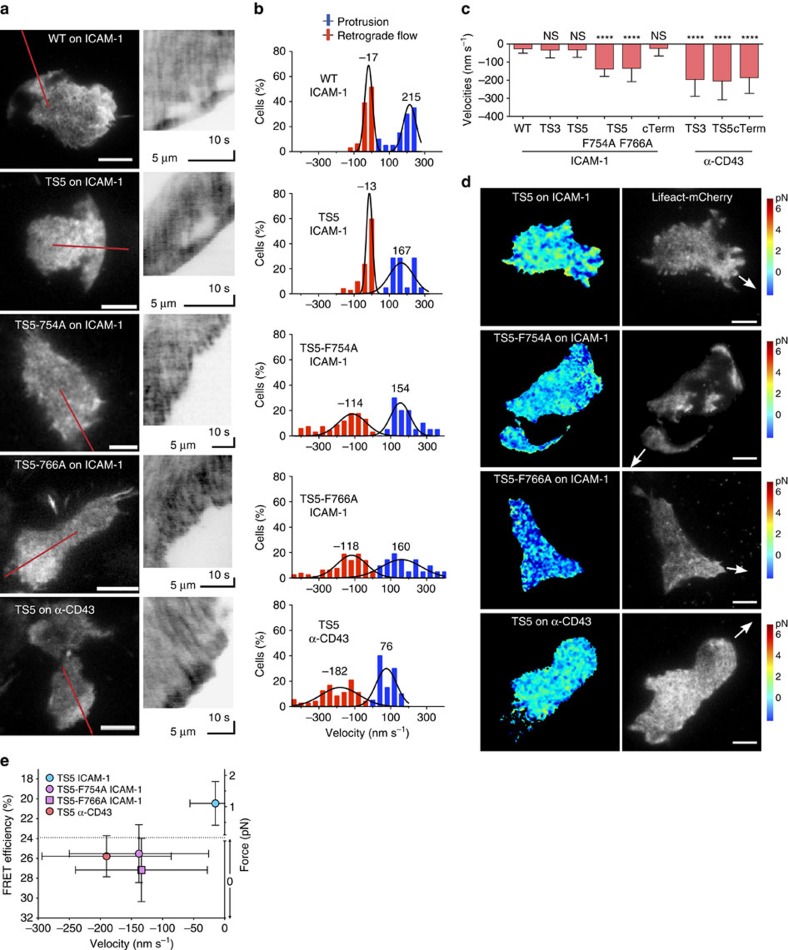
Strong actin retrograde flow in conditions with low integrin tension.(a) TIRF images of Lifeact-mCherry in migrating Jurkat T cells with 100 ng ml−1 SDF-1α. Red lines show regions from which kymographs (right) were generated. Images are from 3 to 6 independent experiments. Scale bar, 5 μm. (b,c) Actin retrograde flow and protrusion velocities from kymographs. Gaussian fits to the data are displayed (N=64, 55, 72, 68, 60, 45, 38, 72, 42 kymographs analysed from 15–25 cells per condition). Values are shown as mean±s.d. Kruskal–Wallis with Dunn's multiple comparison test of differences between WT cells and other conditions yielded P values: ****P<0.0001. (d) Representative FRET (colour) and actin (grey scale) images before start of high-speed actin movies quantified in b. The arrows indicate the direction of cell movement. Scale bar, 5 μm. Images are from three independent experiments. (e) FRET and force versus actin retrograde flow. FRET data from Figs 3b and 4b are shown with retrograde flow data from d as mean values±s.d.